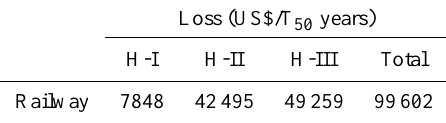
Table 12. Indirect risk to the railway.